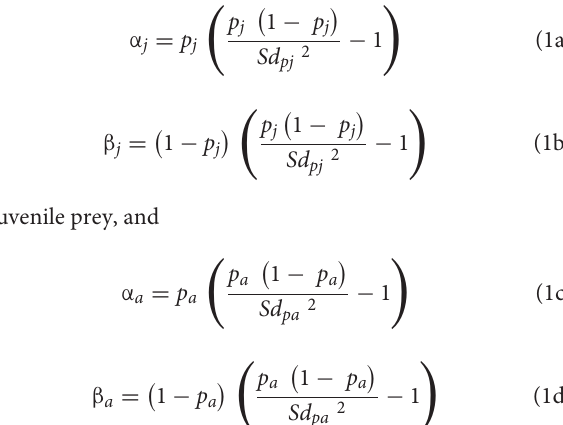
Beta distributions with shape parameters α j and β j and α a and β a for juvenile and adult prey, respectively, and differed from one individual to another, allowing to integrate individual heterogeneity. However, new probabilities were drawn each year and were not preserved through the individual’s life, and thus varied randomly within individuals from year to year.